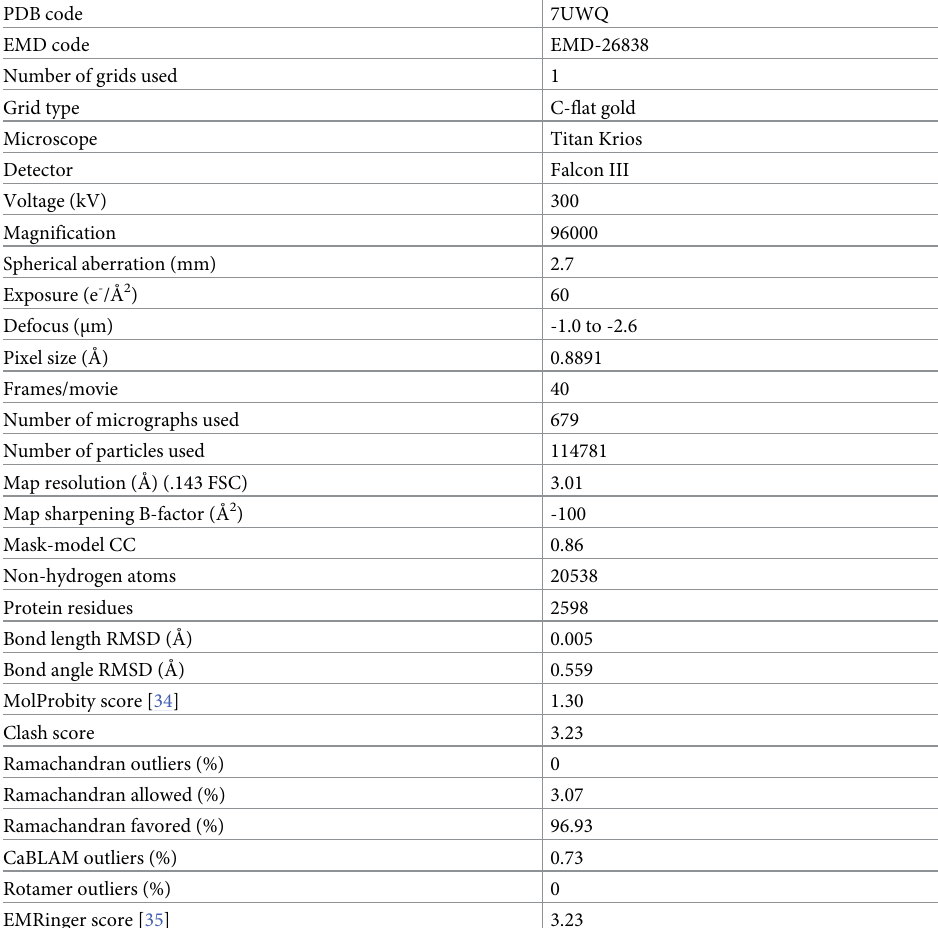
Table 2. Cryo-EM data collection and refinement